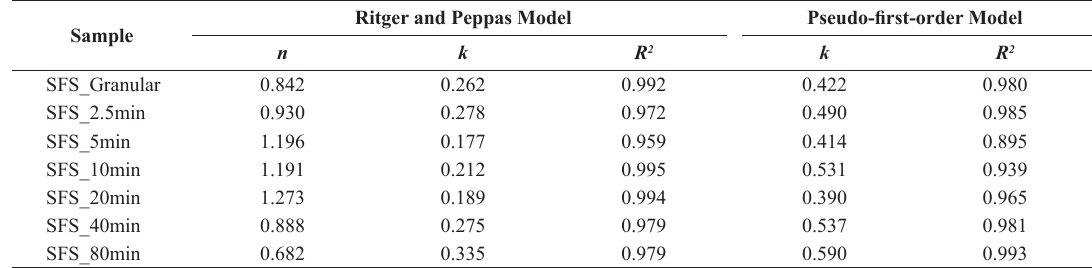
Ritger and Peppas